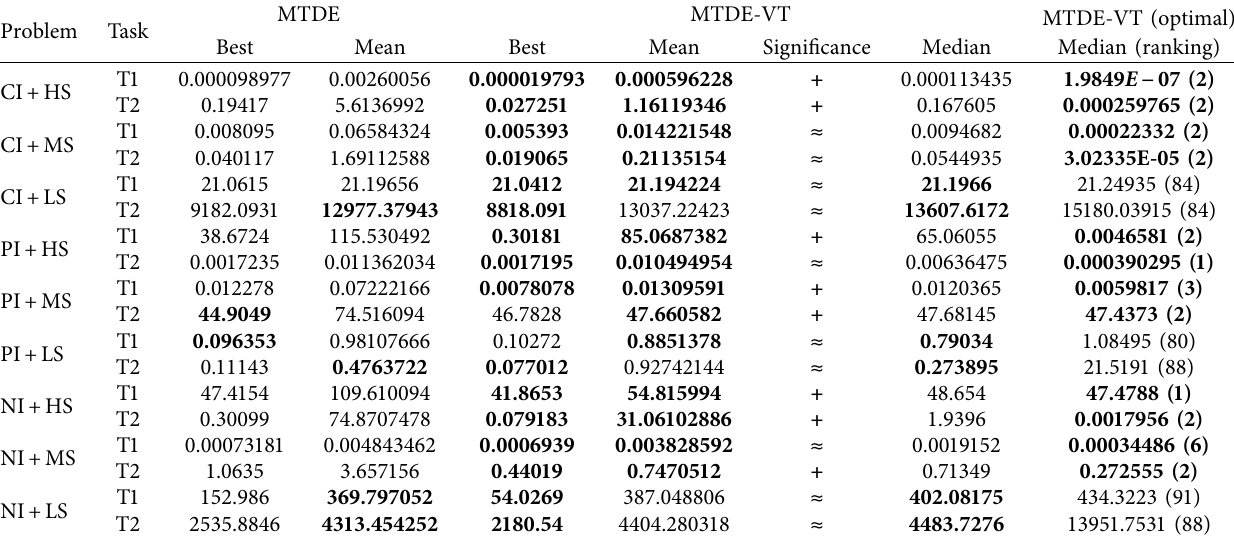
Table 1: Optimal solution obtained by the MTDE and MTDE-VT